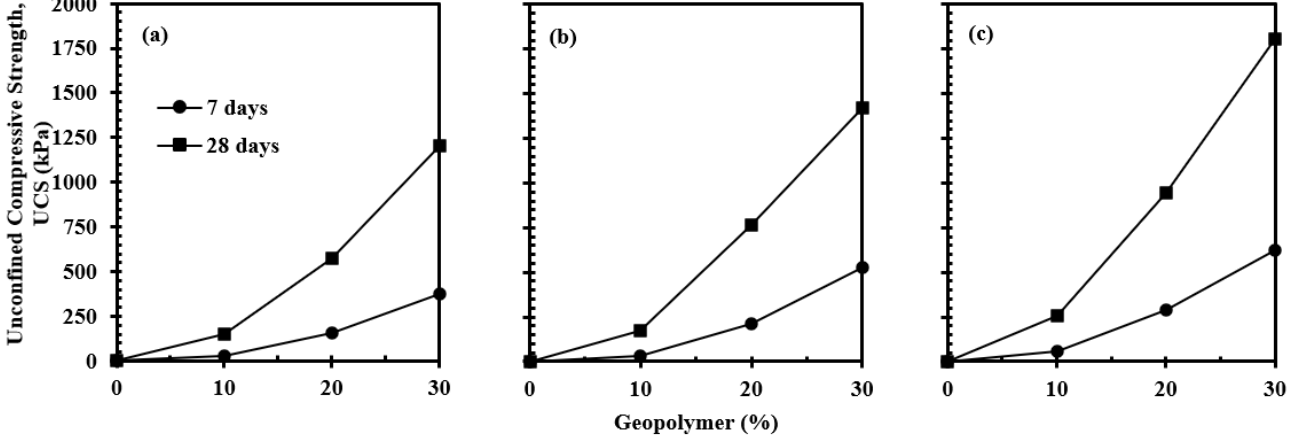
Figure 4. Effect of geopolymer content on peak strength of treated clay at 7 and 28 curing days for different activator-to-binder (A/B) ratios: ( a ) A/B = 0.5; ( b ) A/B = 0.75; and ( c ) A/B = 1.0.